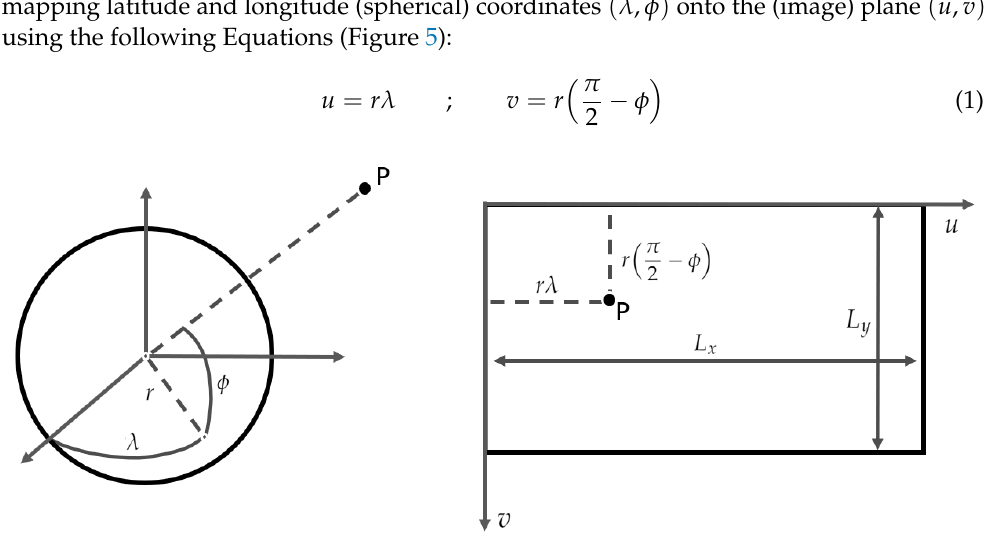
Figure 5. Conversion from spherical coordinates ( λ , φ ) to pixel coordinates ( u , v ) based on an equirectangular